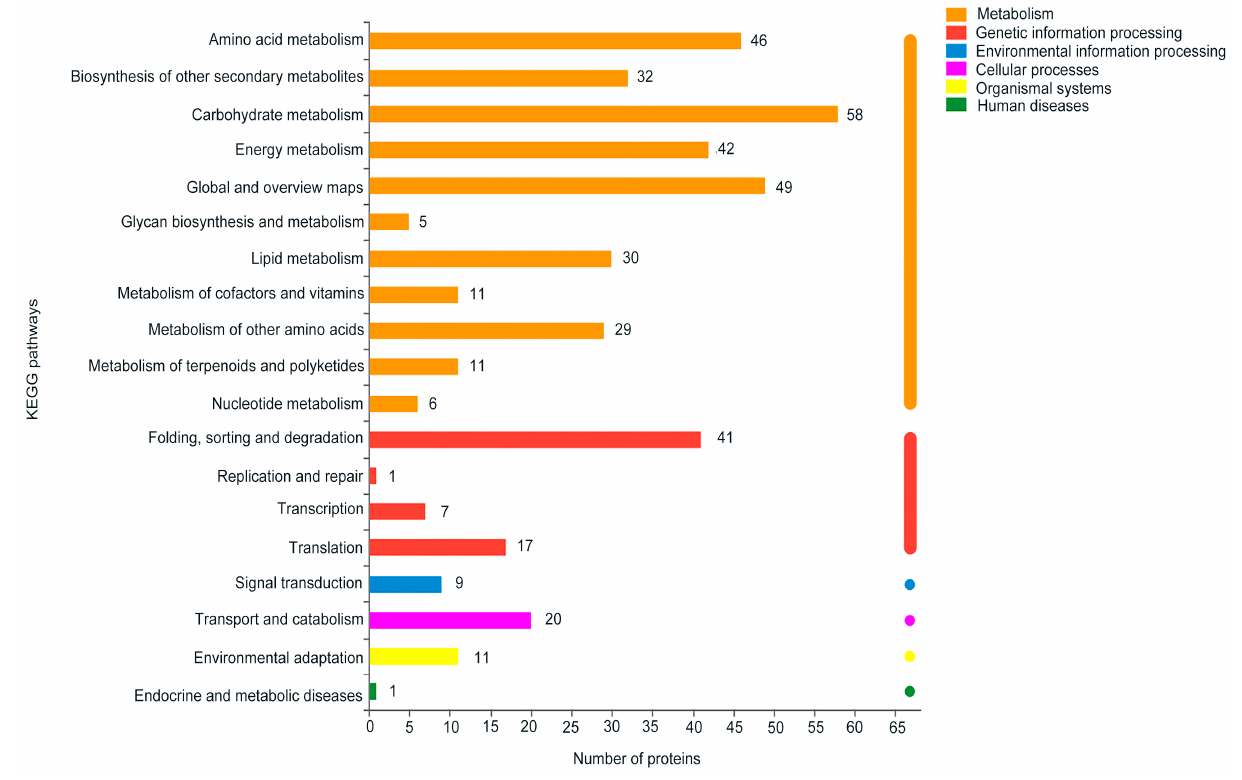
Figure 6. The Kyoto Encyclopedia of Genes and Genomes (KEGG) pathway annotation of DEPs.